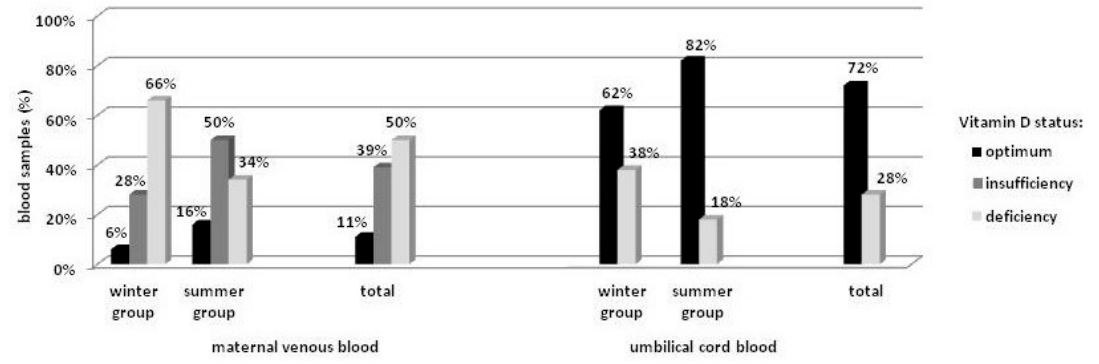
Figure 1. Distribution of vitamin D concentration in the blood.